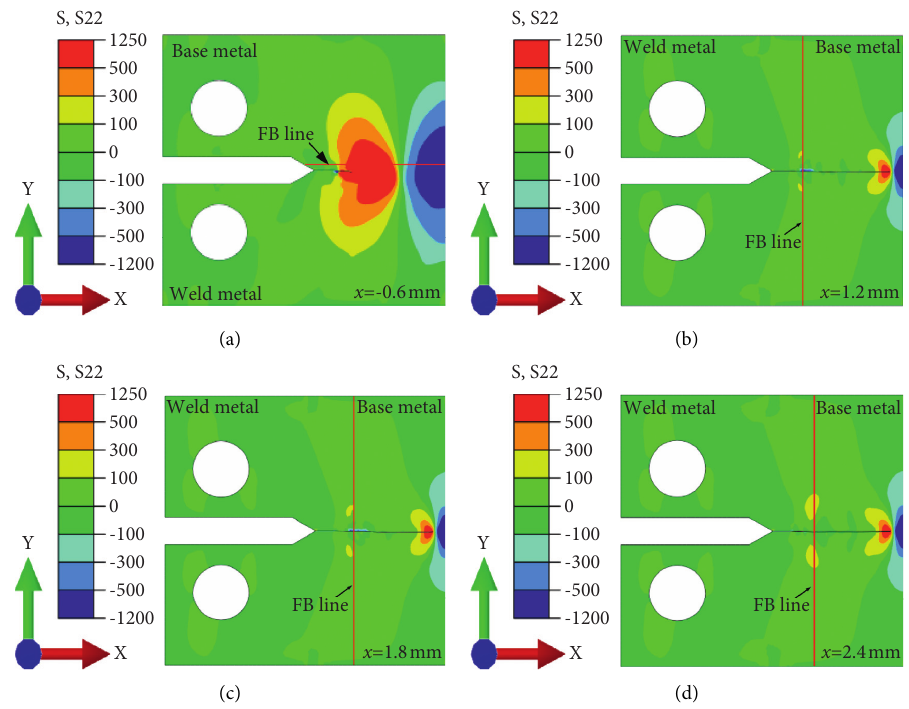
Figure 9: Crack extension path and tensile stress distribution of transverse cracks: (a) x � 0.6, (b) x � 1.2, (c) x � 1.8, and (d) x � 2.4.